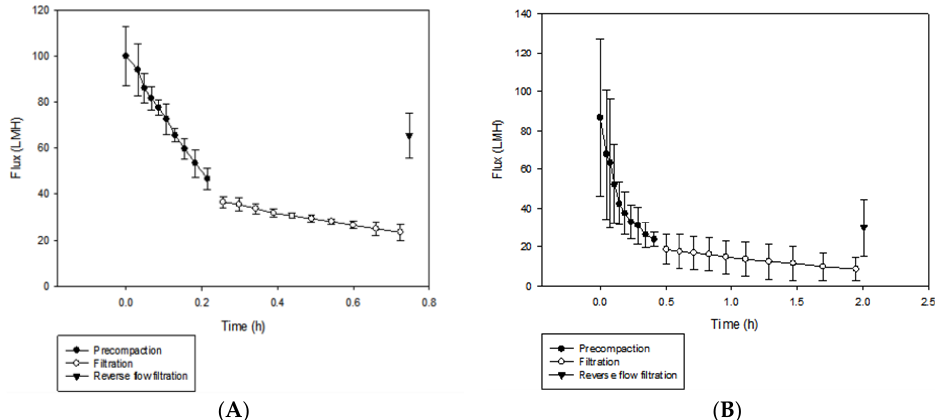
Figure 13. ( A ) Flux analysis of SPEEK: PSf membranes and ( B ) phosphorene membranes.